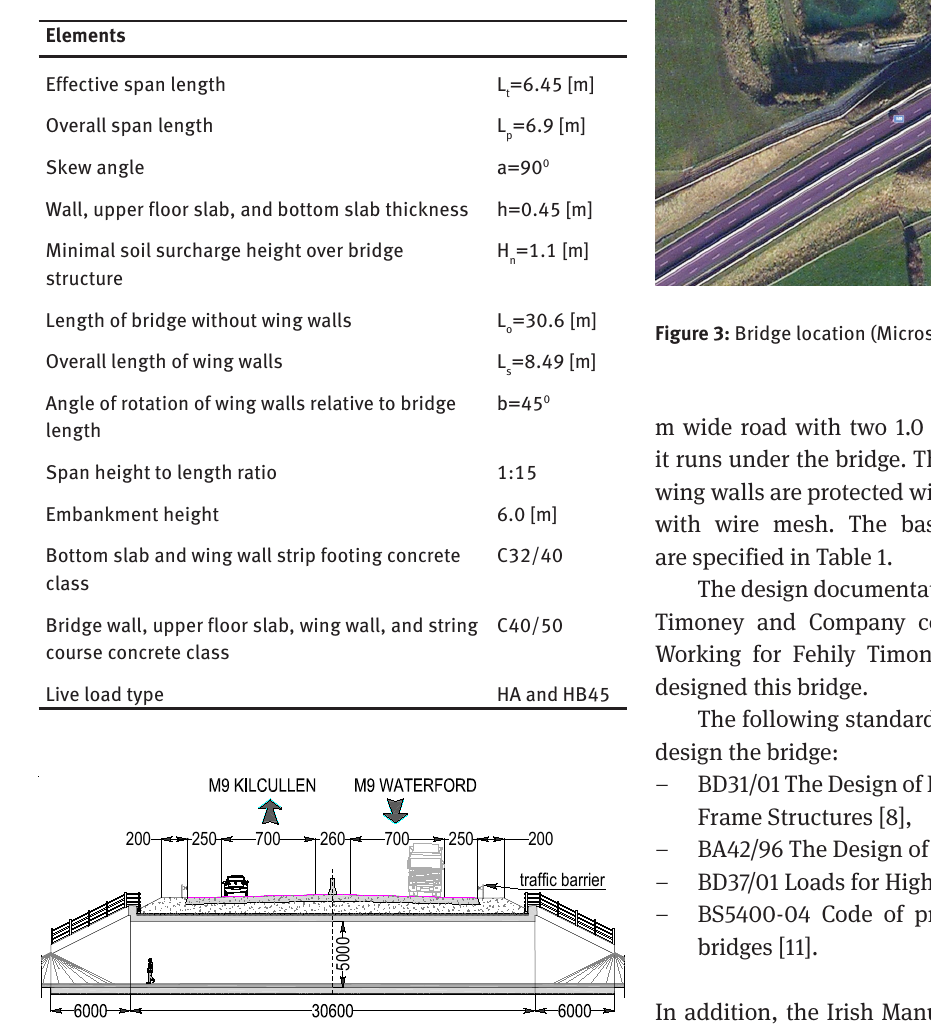
Table 1: Basic bridge parameters.